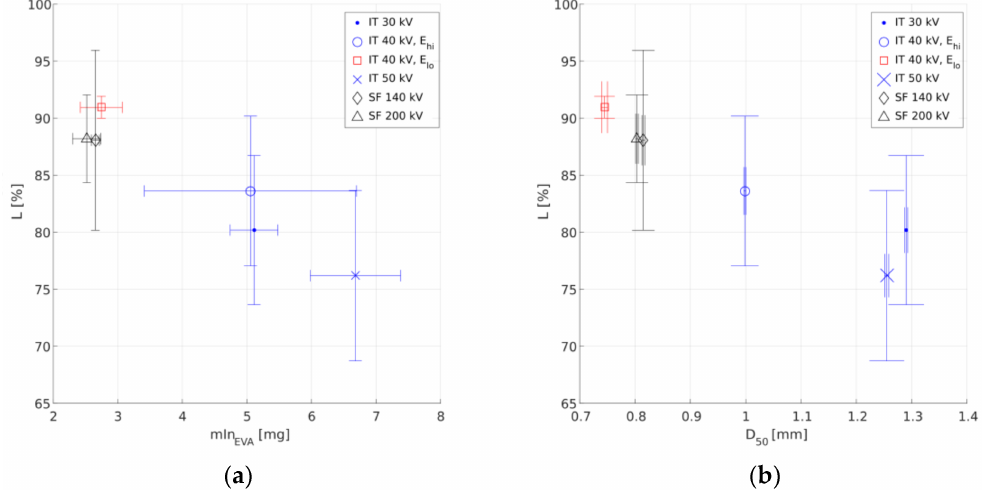
Figure 8. Comparison of liberation (L) with: ( a ) Residual indium content of EVA film pieces (mIn EVA ) and; ( b ) Median particle size (D 50